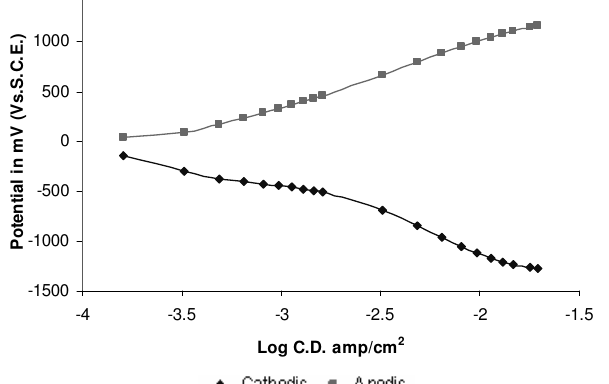
Anodic Figure 2 . Effect of varying current density on the cathode and anode potential of tin coated steel in 0.5M monochloroacetic acid in the presence of 0.1% Potassium chromate